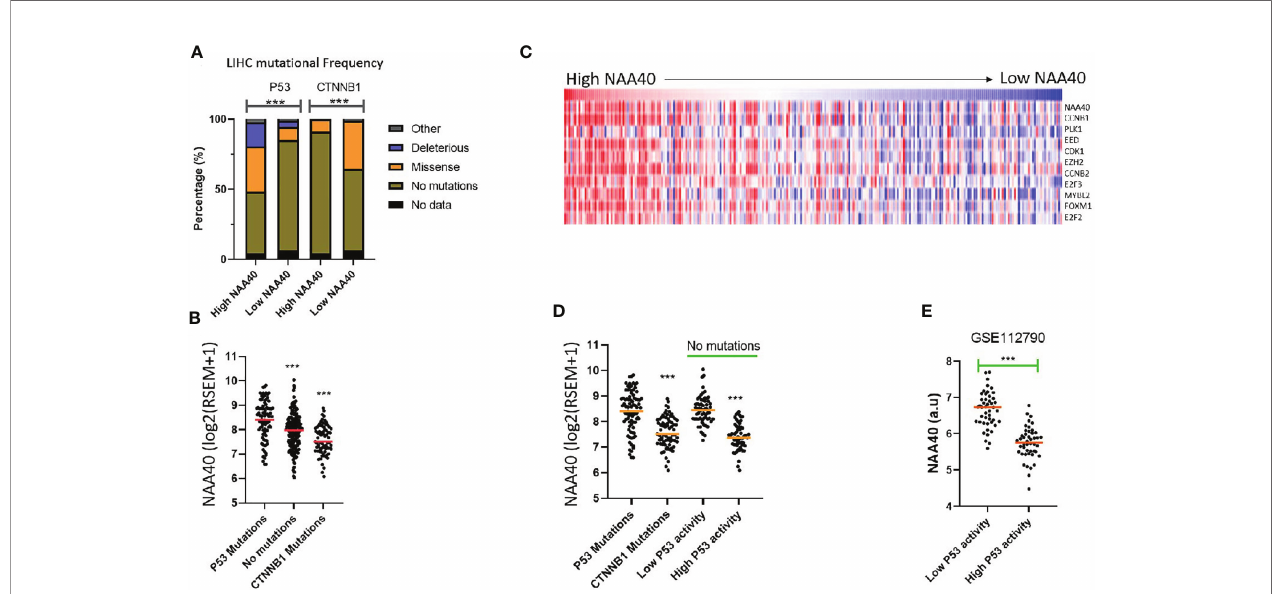
FIGURE 4 | NAA40 upregulation coincides with inactivation of P53 in LIHC (A) Stacked bar charts displaying frequencies of TP53 and CTNNB1 mutations in High and Low NAA40 LIHC groups; (B) Expression of NAA40 in TCGA LIHC tumours with mutations of TP53, CTNNB1, or neither of the two genes; (C) Heatmap comparing expression of NAA40 with ten p53-repressed genes which de fi ne a signature indicative of P53 activity; (D) Comparison of expression of NAA40 in tumours with P53 mutations, CTNNB1 mutations, and in tumours with no mutations in either of these two genes but divided into top and bottom quartiles of p53 activity according to p53-repressed gene signature; (E) Comparison of NAA40 levels in an independent LIHC cohort (GSE112790) demarcated into top and bottom quartiles based on signature of P53 repressed genes; In the scatterplots each circle represents an individual sample and orange line depicts the median value ***p < 0.001 Student ’ s